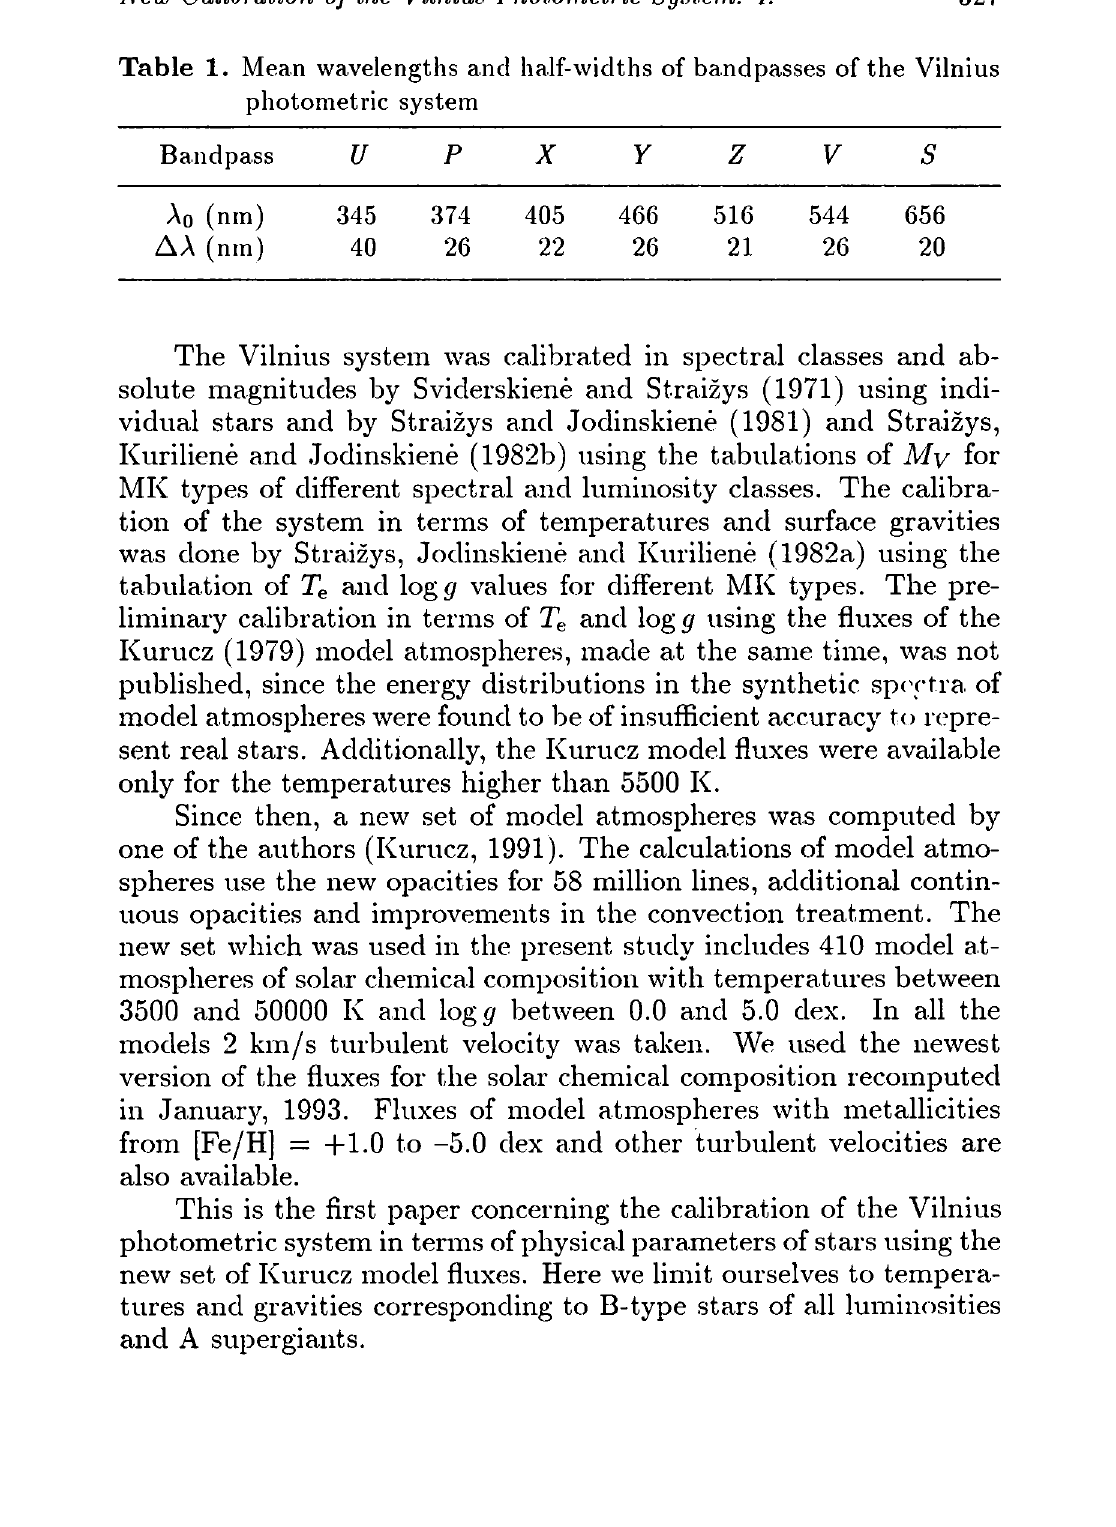
Table 1. Mean wavelengths and half-widths of bandpasses of the Vilnius photometric